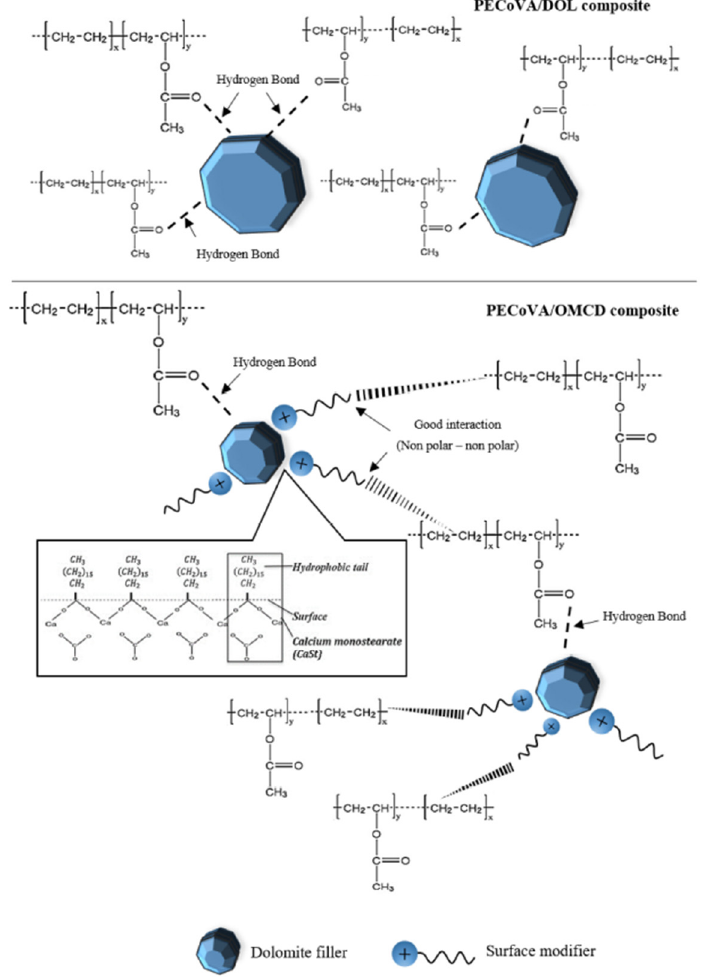
Figure 11. The proposed interactions between the PECoVA copolymer chain with DOL and OMCD fillers in the PECoVA composite system. Reprinted with permission from Ref. [13].